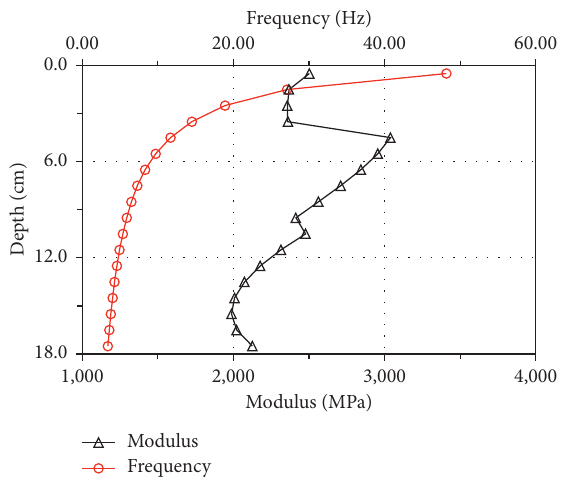
Figure 6: Modulus and frequency along with depth